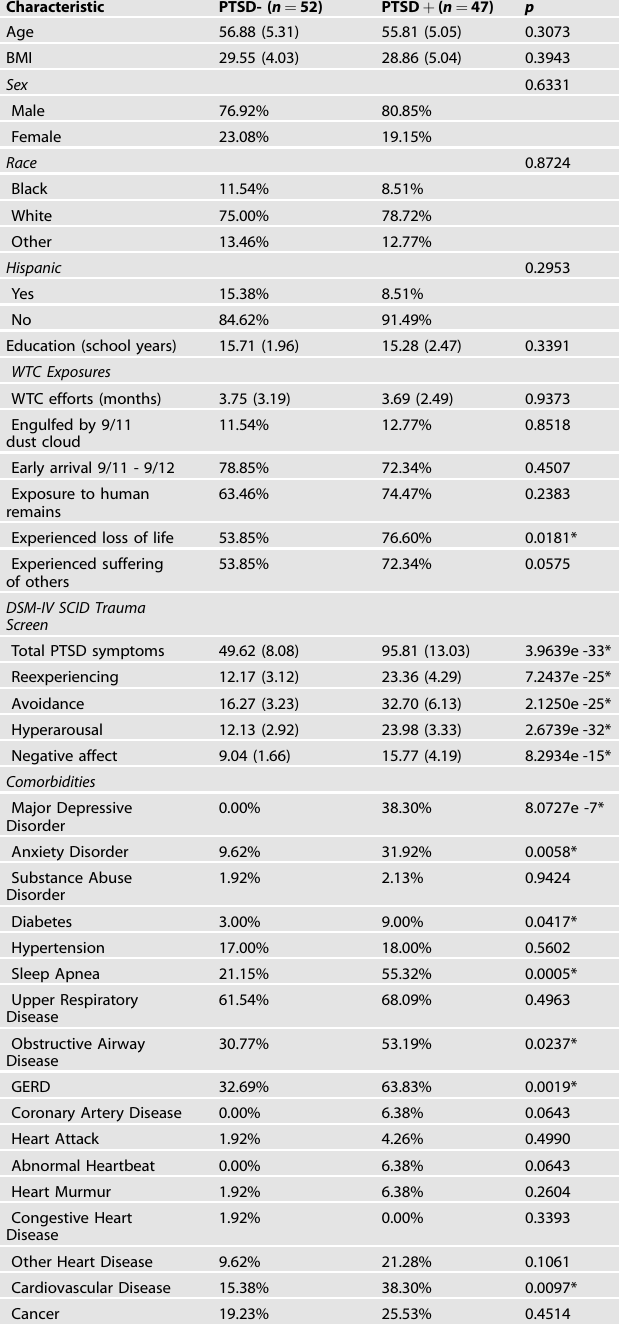
Table 1. Sample ( n = 99) characteristics for WTC responders with and without PTSD